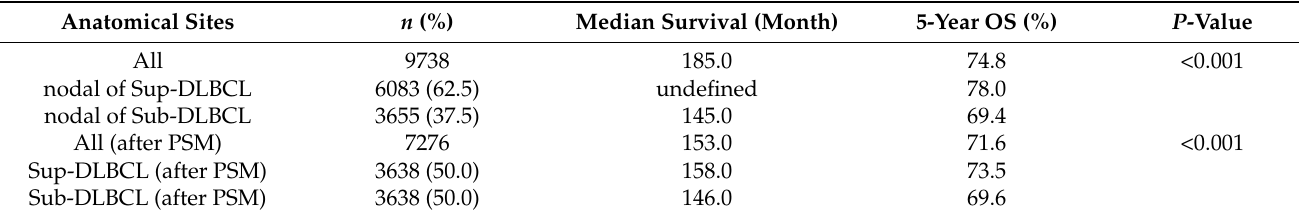
Table 2. Overall survival (OS) of patients with early-stage nodal DLBCL according to primary sites. Anatomical